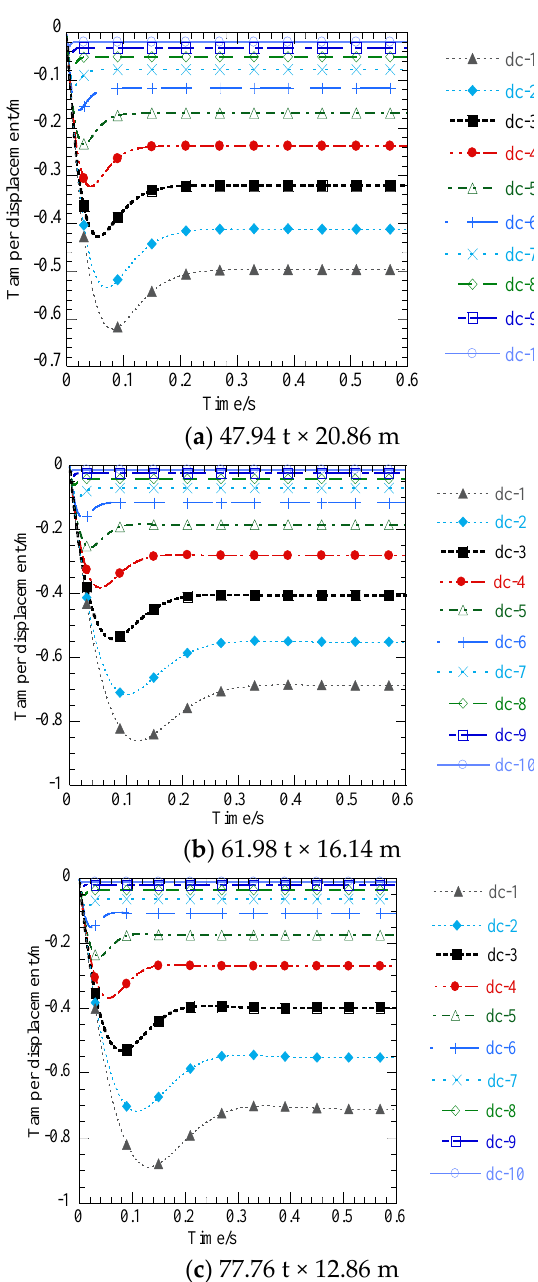
Figure 6. Time history of the tamper displacement at different energy